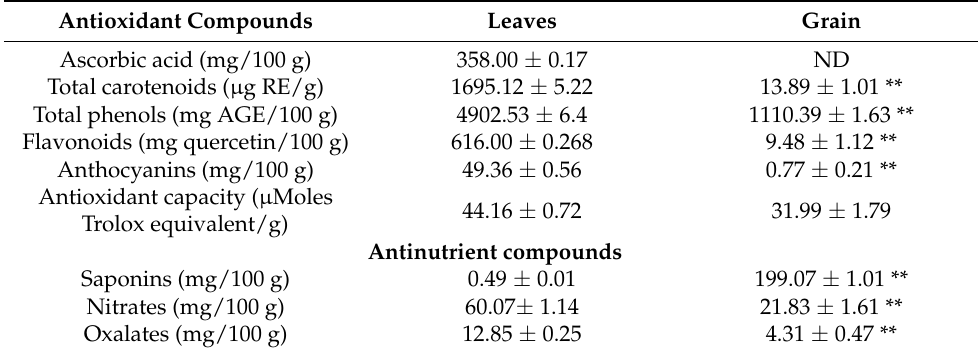
Table 4. Antioxidant and antinutrient compounds in quinoa leaves and grains (dry weight of the